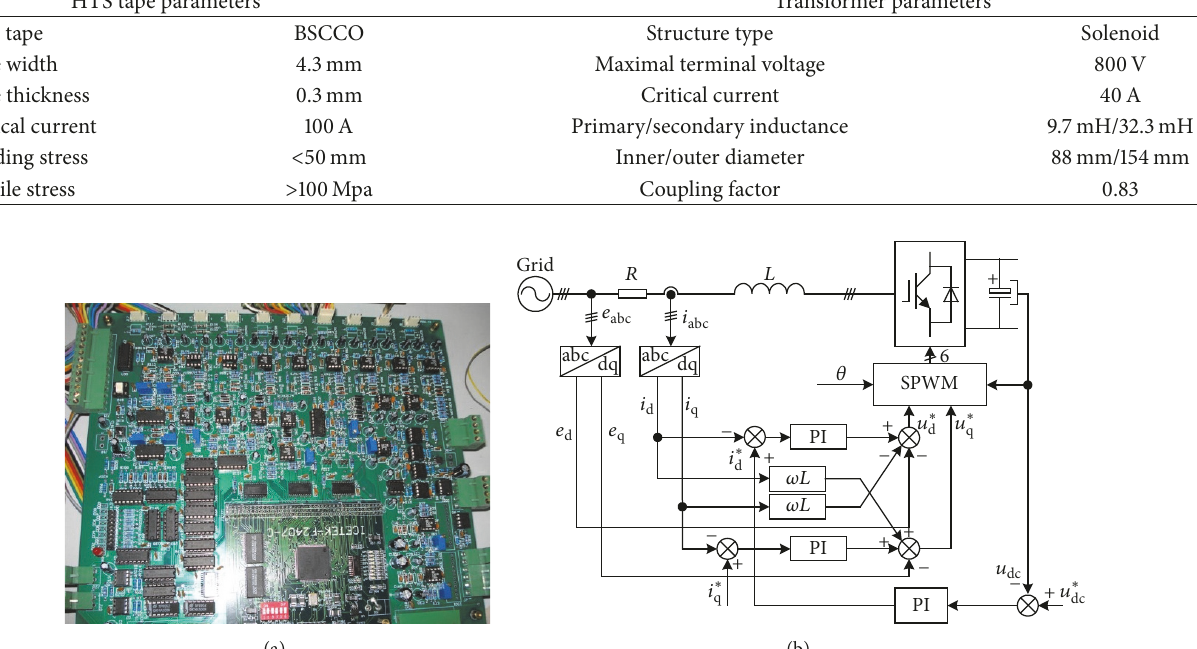
Figure 4: (a) Control panel based on the digital signal processor (DSP) TMS320LF2407A. (b) Control block diagram of the AC/DC power converter.